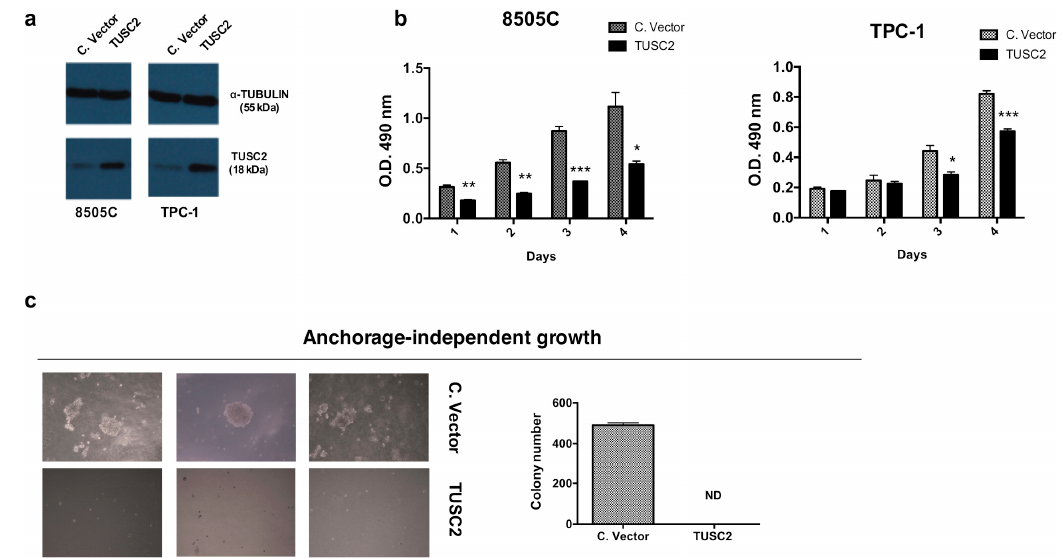
Figure 1. Tumor Suppressor Candidate 2 (TUSC2) forced expression reduced thyroid cancer cell proliferation. ( a ) Western blot analysis of TUSC2 and TUBULIN protein levels in a selected mass population of 8505C and of TPC-1 cells after stable transfection with TUSC2 or Control Vector (C.Vector) plasmid. ( b ) MTS assay was performed to evaluate the proliferation rate in 8505C (left) and TPC-1 (right) cell lines after stable TUSC2 transfection. Absorbance at O.D. 490 nm was measured every 24 h for four days. Data represent the mean of three experiments ± standard errors. ( c ) Colony formation ability of 8505C cells stably transfected with TUSC2 or with Control Vector (C. vector) was examined by soft agar assay to determine anchorage-independent growth. Cells were cultured in semisolid medium and after three weeks of plating, the colonies were imaged (left) and counted (right) under a microscope at 10x magnification. The experiment was performed in triplicate. ND: Not detected.